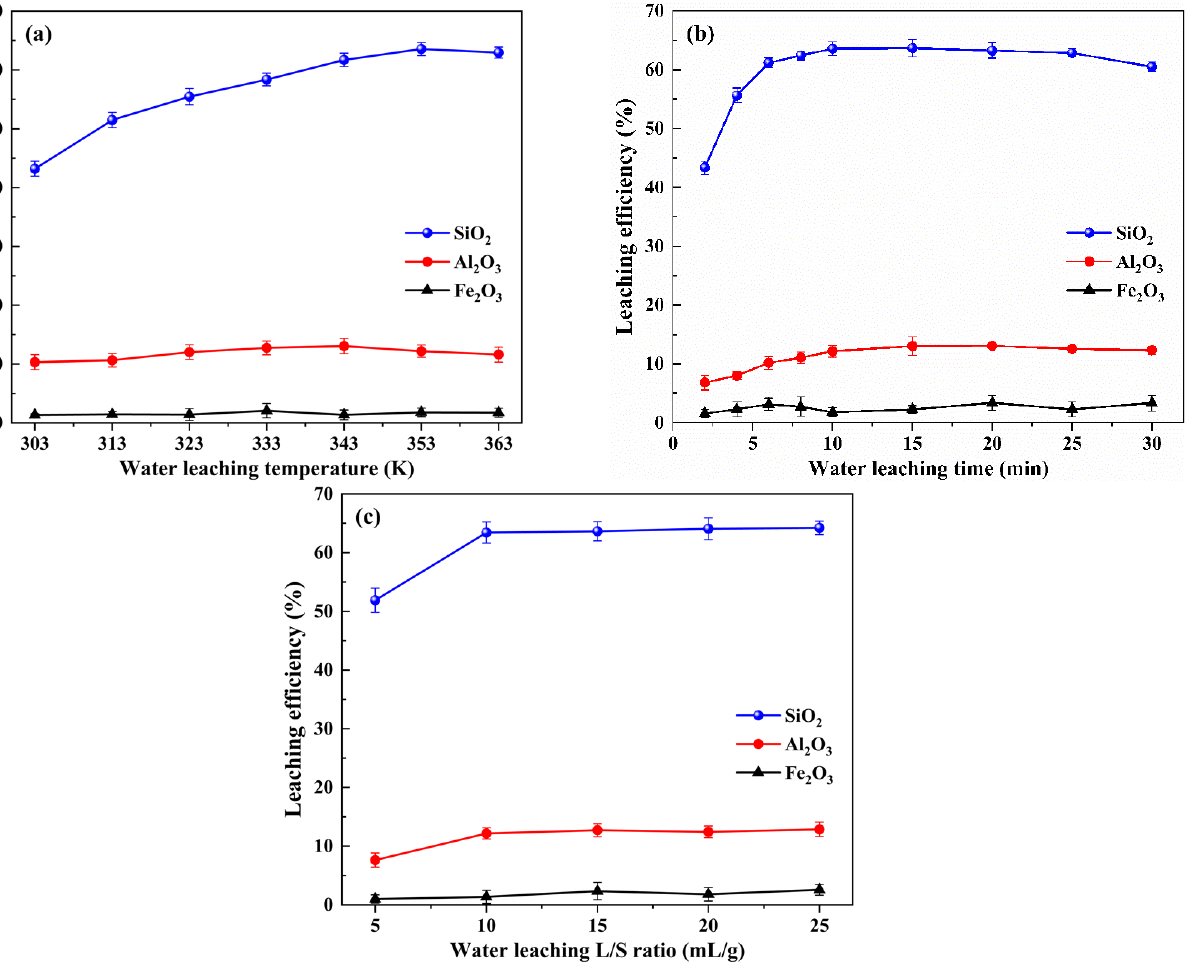
Figure 3. Effects of different water leaching conditions on the leaching efficiencies of silicon, aluminum and iron: ( a ) leaching temperature, ( b ) leaching time and ( c ) liquid–solid ratio.